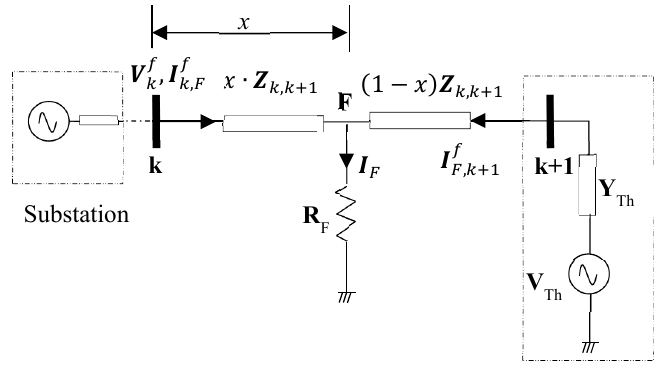
Figure 9. Distribution system representation with fault upstream to the DER.